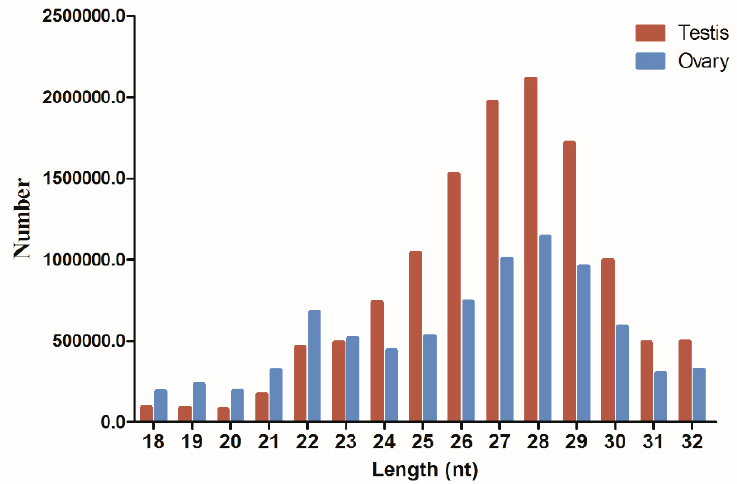
Figure 1 . Length distributions of the small RNA sequences in the testis and ovary of the yellowfin seabream.